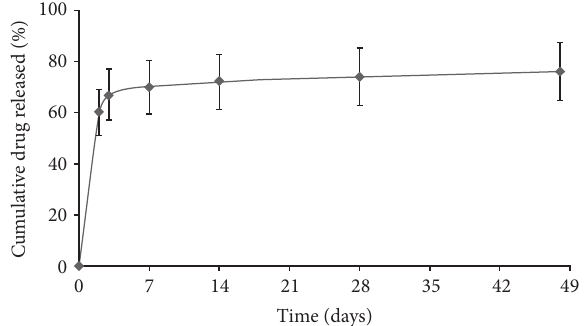
Figure 4: Drug release kinetics of the Supraflex sirolimus-eluting